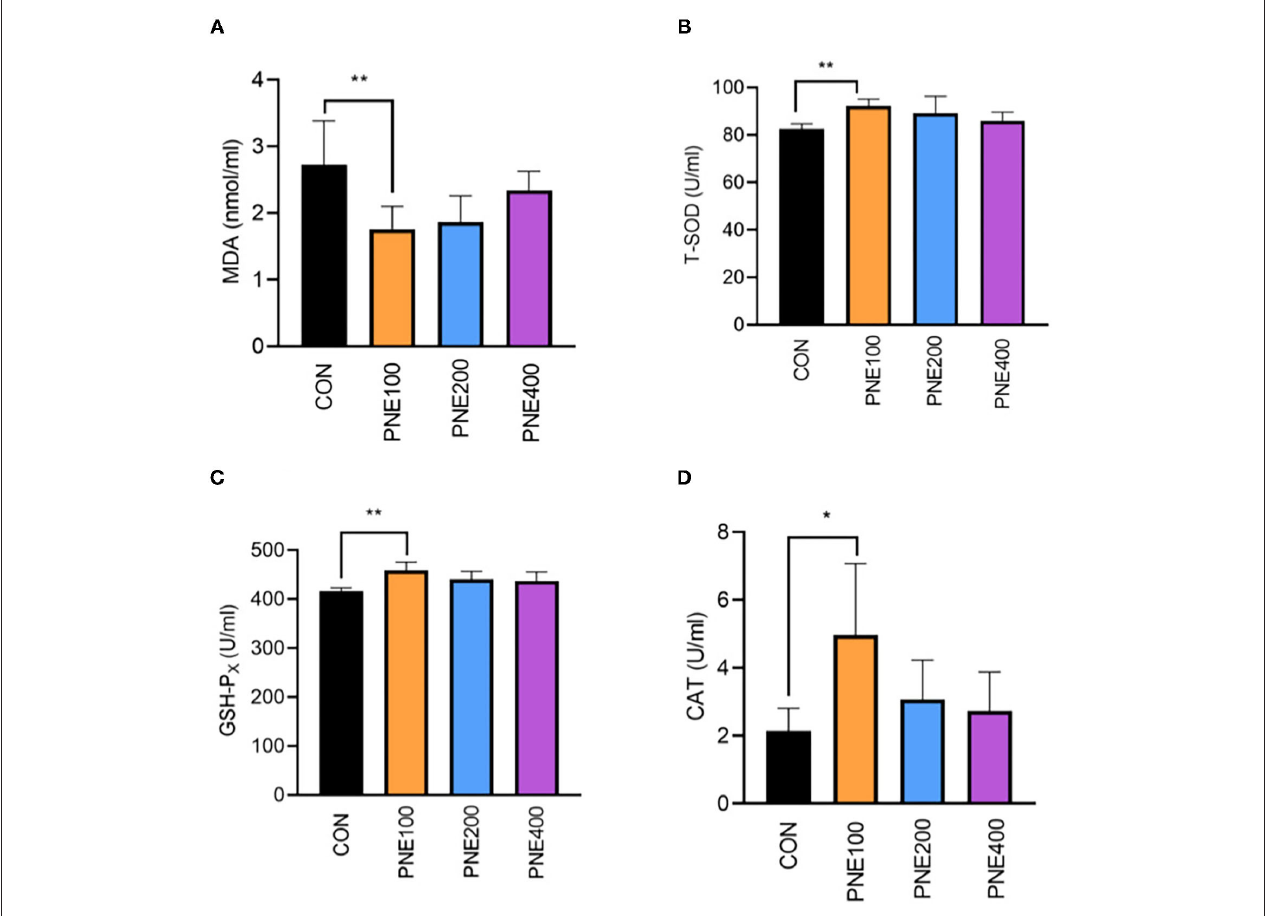
FIGURE 3 | Effect of pine needle extract (PNE) supplementation on serum antioxidant parameters MDA (A) , T-SOD (B) , GSH-PX (C) , and CAT (D) of laying hens. MDA, malondialdehyde; T-SOD, total superoxide dismutase; GSH-Px, glutathione peroxidase; CAT, catalase. Asterisks denote significant differences (* p ≤ 0.05, ** p ≤ 0.01), n = 6 per group, data are expressed as means ±